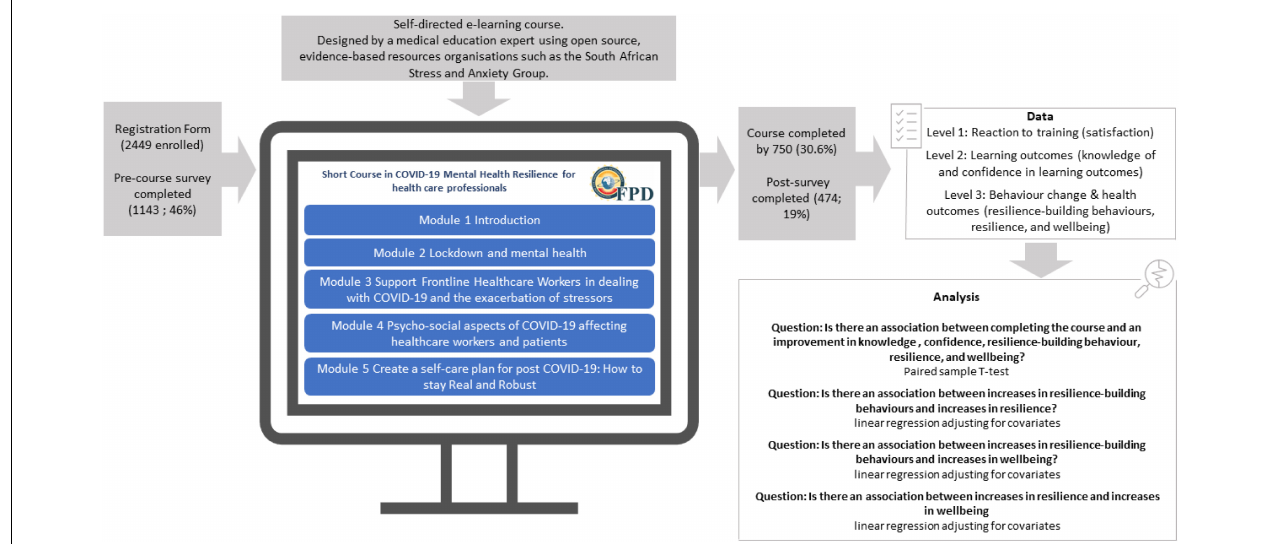
FIGURE 1 | Research